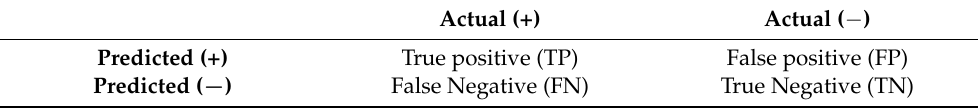
Table 4. Confusion